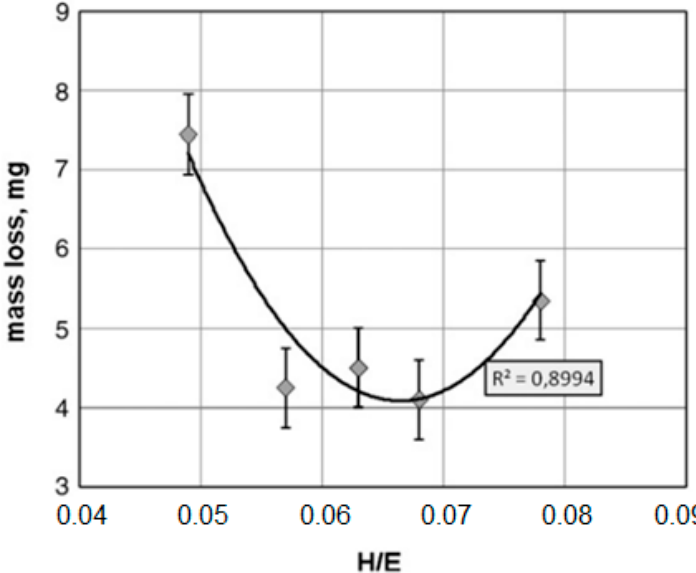
Figure 7. Correlation between H / E ratio and mass loss in cavitation tests of 4 µ m thick TiN coatings deposited on X6CrNiTi18-10 steel by means of a cathodic arc evaporation PVD method, reprinted from Surface and Coatings Technology , Reference [92], with permission from Elsevier.